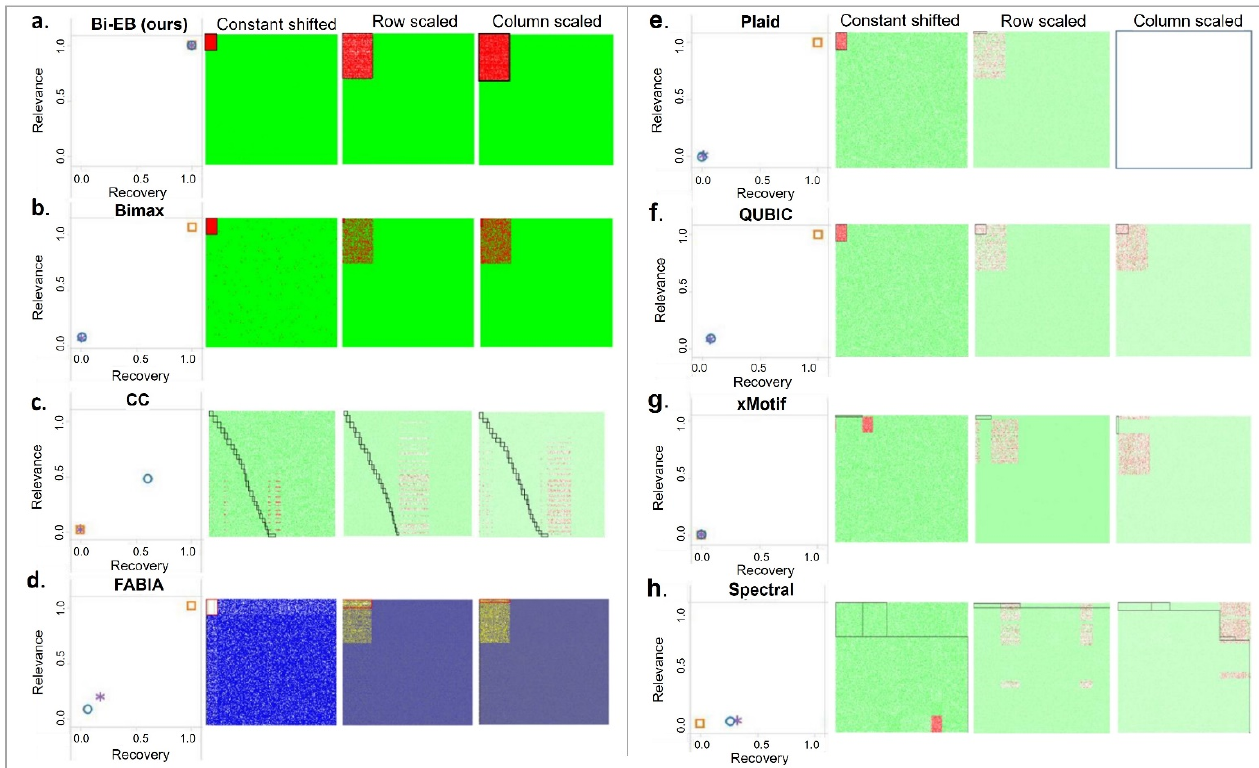
Figure 3. Bicluster model evaluation. Each group represents the average recovery versus relevance between the TRUE and predicted values in the biclustering algorithms: ( a ) BI-EB; ( b ) Bimax; ( c ) CC; ( d ) FABIA; ( e ) Plaid; ( f ) QUBIC; ( g ) xMotif; and ( h ) spectral relevance to constant-shifted, row-scaled, and column-scaled biclusters.